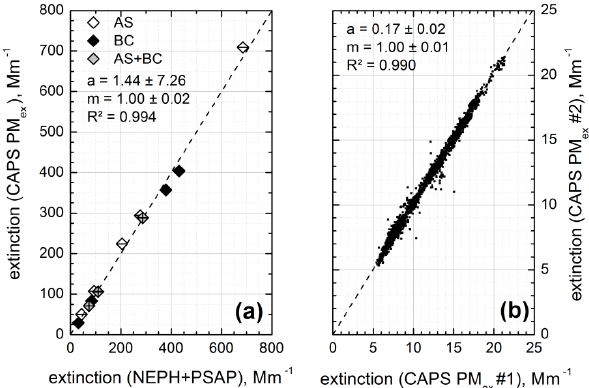
Figure 7. Panel (a) Accuracy: Intercomparison of extinction measured by CAPS PM ex and Fig. 7. (a) Accuracy: intercomparison of extinction measured by CAPS PM ex and extinction obtained from the combined extinction obtained from the combined NEPH+PSAP analysis for polydisperse laboratory NEPH + PSAP analysis for polydisperse laboratory aerosols; all aerosols; all data refer to a wavelength of 630 nm and the error bars indicate 1-  of the mean data refer to a wavelength of 630 nm and the error bars indicate for respective averaging periods. Panel (b) Precision: Intercomparison of two CAPS PM ex 1- σ of the mean for respective averaging periods. (b) Precision: in- tercomparison of two CAPS PM ex monitors operated side-by-side monitors operated side- by- side while sampling from laboratory air at temperature-controlled while sampling from laboratory air at temperature-controlled and and dry conditions with 15s time resolution. The dashed lines represent the 1:1 ratio. dry conditions with 15s time resolution. The dashed lines represent the 1 : 1